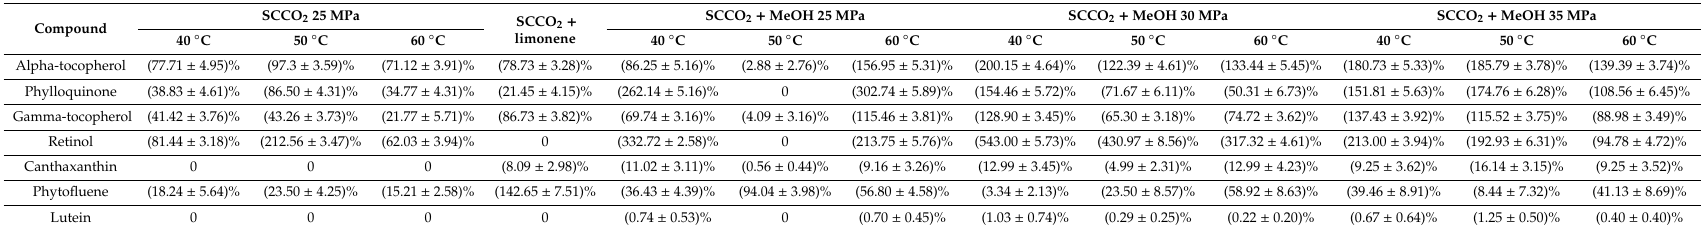
Table 1. The SFE extraction yields of alpha tocopherol, phylloquinone, gamma-tocopherol, retinol, canthaxanthin, phytofluene, and lutein using di ff erent experimental conditions. The values reported are expressed as percentages of MSPD extraction yields ± standard